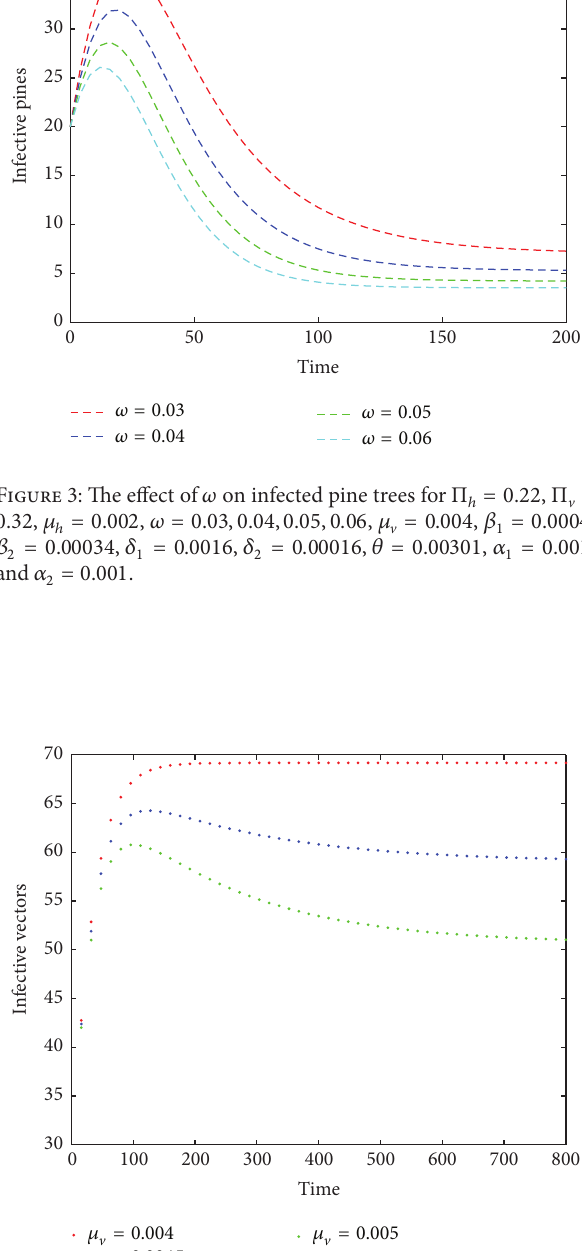
= 0.0004 , 1 = 0.001 , 1